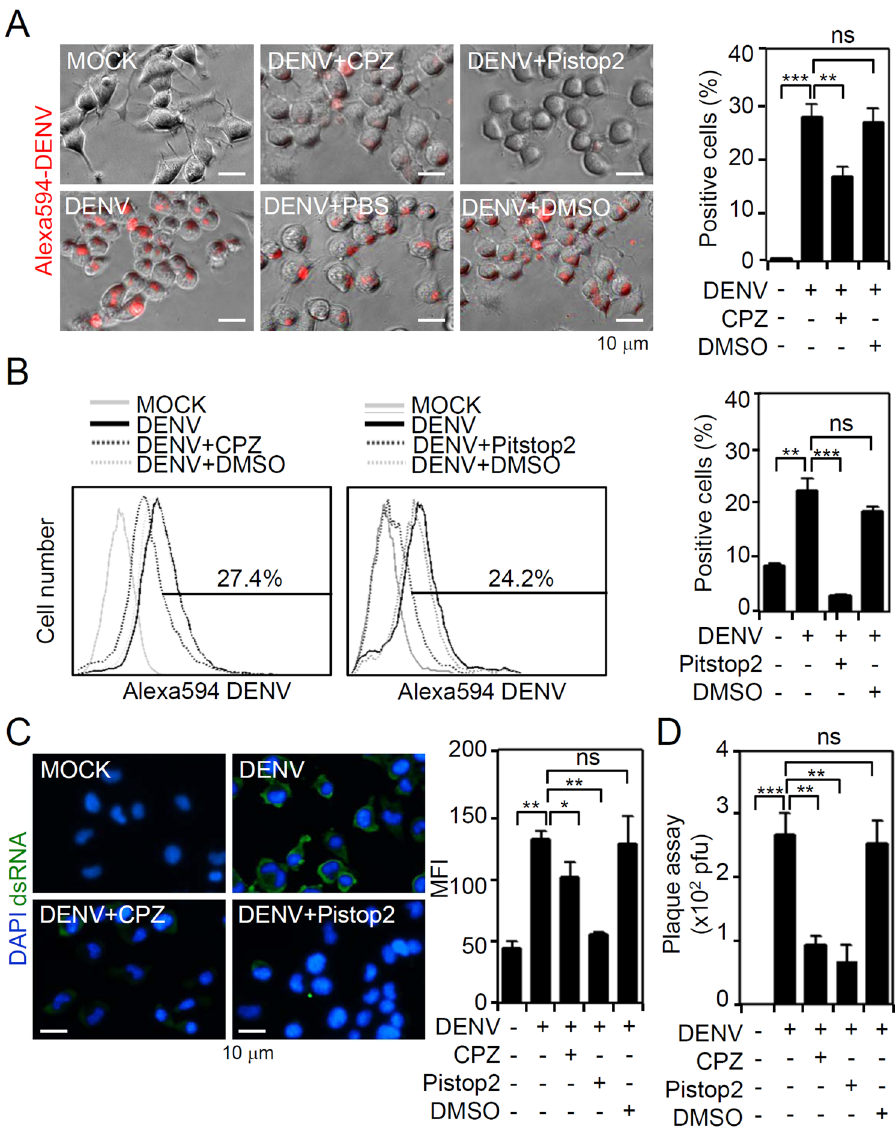
Figure 2. Inhibition of clathrin-mediated endocytosis partly reduces dengue virus serotype 2 (DENV2) infection in Neuro-2a cells. Neuro-2a cells were inoculated with Alexa-594-labeled DENV2 (at a multiplicity of infection of 1) for 2 h in the presence of the clathrin inhibitors, chlorpromazine (CPZ; 5 ng/ml) and Pitstop2 (30 µ M). ( A ) Fluorescent microscopy and ( B ) flow cytometry were respectively used to measure the expression and percentage of cells carrying fluorescent DENV2. ( C ) Immunocytochemistry and the relative mean fluorescence intensity ( MFI ) of viral dsRNA ( green ) 24 h post-infection. ( D ) Plaque assays show the level of viral replication 24 h post-infection. For all images, representative data were selectively obtained from three individual experiments. Quantitative data are depicted as the mean ± SD. * p < 0.05, ** p < 0.01, and *** p < 0.001. ns, not